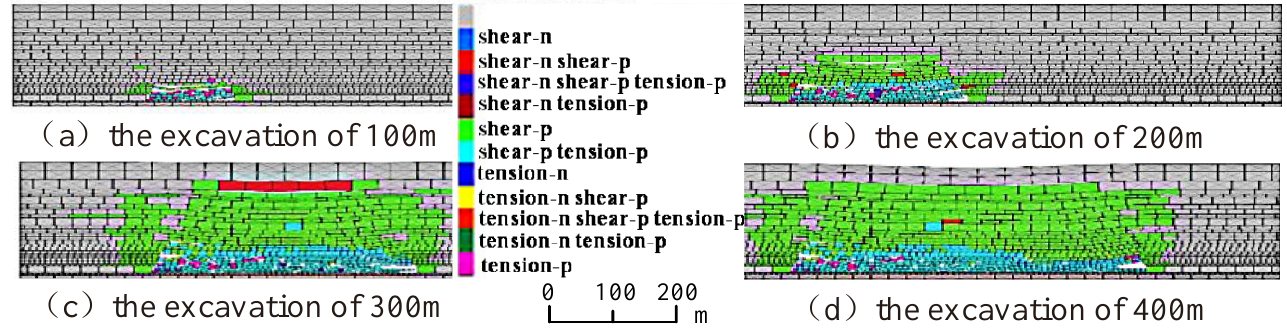
Figure 5. ( a – d ) describes the dynamic distribution of the plastic zone in overlying strata during different excavation periods of 100 m, 200 m, 300 m and 400 m.